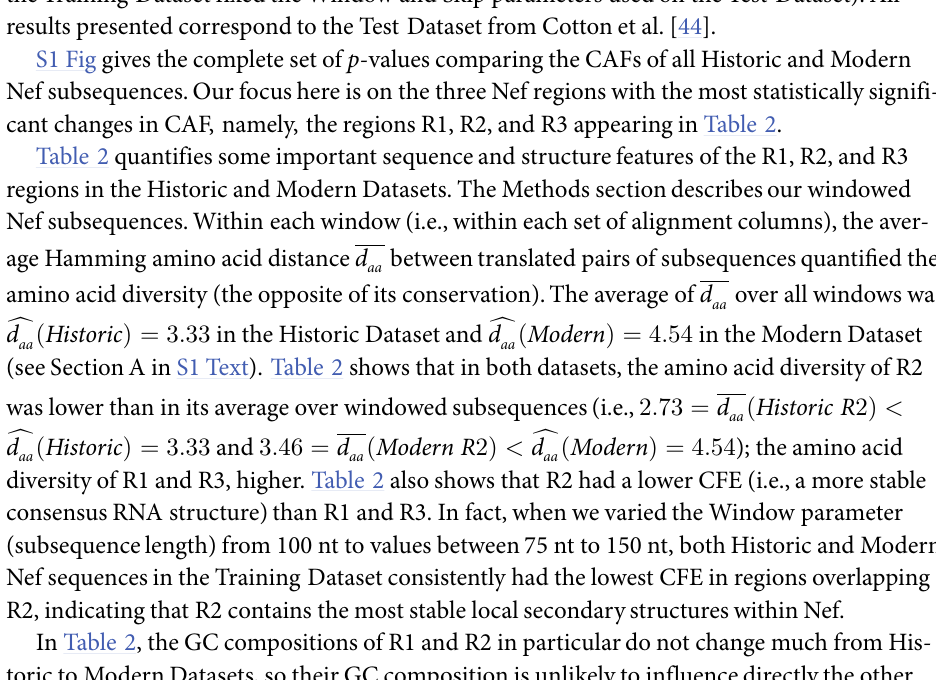
Values with symbol ± denote mean ± standard deviation. The p -values in bold are significant at FDR levels 0.001. FDR calculations were performed separately for each measure of CFE, GC, and